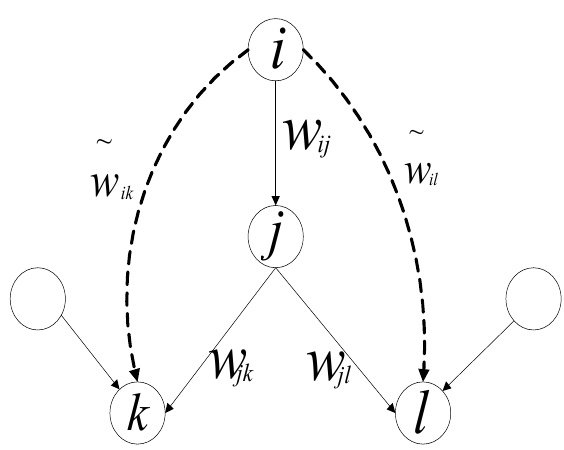
Figure 2. Representation of direct and indirect ownership in a cross-shareholding network.